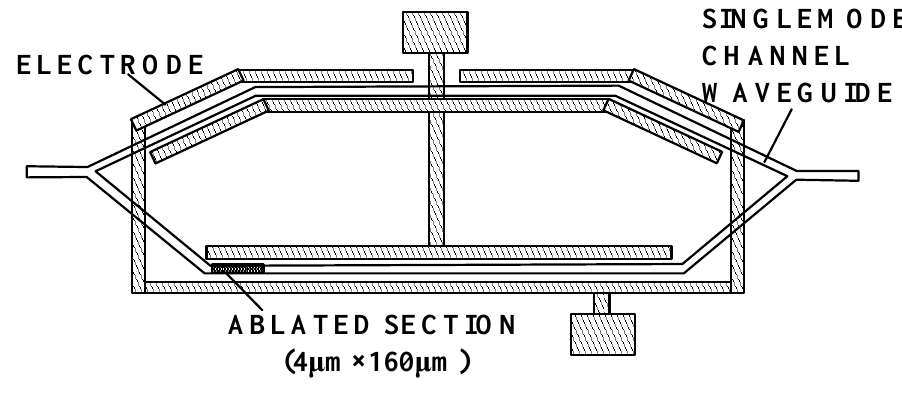
Figure 4. IOES produced by NRL; the optical bias φ (Copyright © 1995 IEEE, Reprinted with